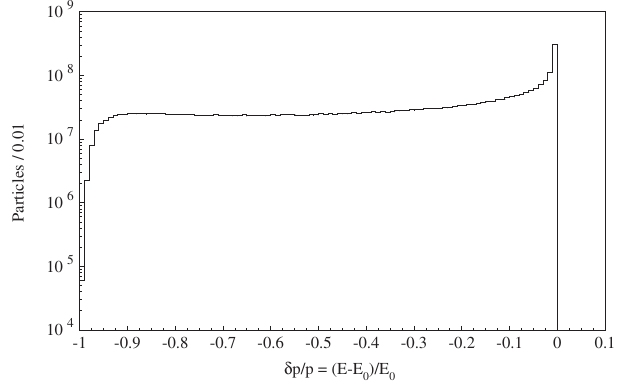
FIG. 2. Relative energy spectrum of the CLIC disrupted beam, obtained with GUINEA-PIG using Gaussian incoming beams and normalized to one